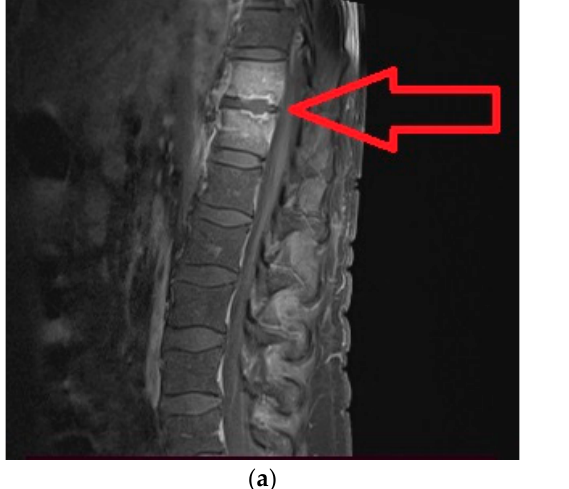
Figure 2. ( a , b ). MRI sagittal section segment dorso-lumbar spine T1 + C TSE FS: contrast enhance- ment at T11, T12 with intervertebral disc involvement. lesion process centred at the level of the intervertebral disc T11–T12 with extension at both adjacent vertebral plates causing osteolysis asso- ciating peripheral contrast enhancement and significant intraspongiosis oedema in both vertebral bodies concerned (T11 and T12).